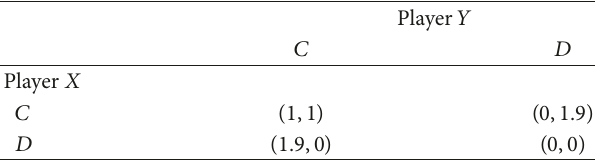
Table 1: The payoffs of Prisoner’s dilemma game. The first value of each pairs is the payoff of player 𝑋 and the second value is the payoff of the player 𝑌